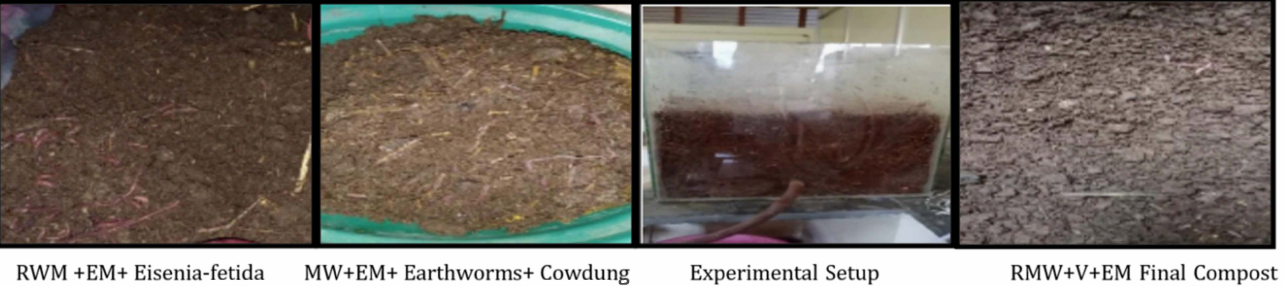
Figure 5. Set up 4 shows the images of raw mushroom waste with vermicomposting EM